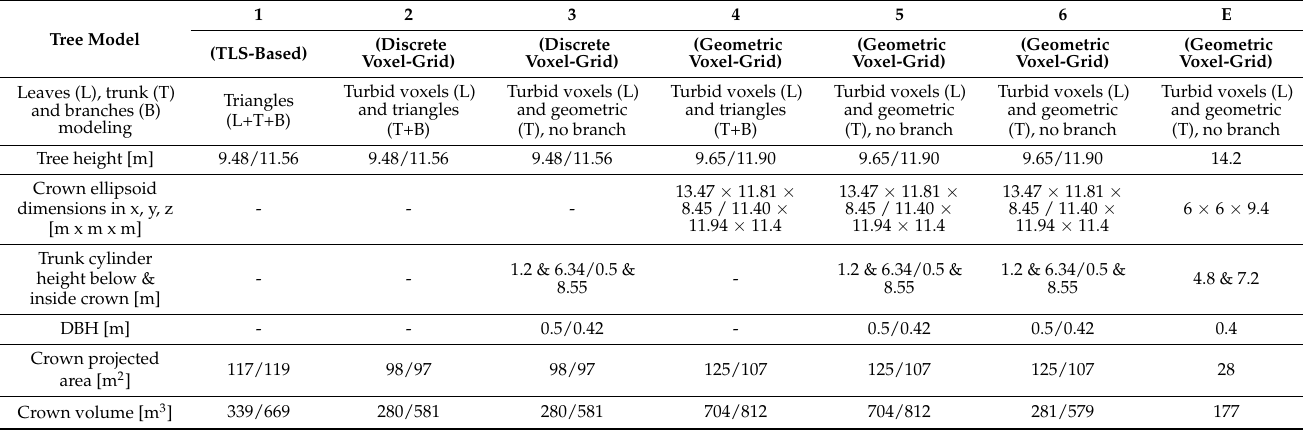
Figure 3. DART 3D mockups of the tree models and NPV (i.e., trunk and branches) for the two species (for global interpretation, dimensions are not respected). Leaves are either represented by triangles (light green color) in the TLS-based tree model n ◦ 1 or simulated as a 3D distribution of voxels filled with turbid medium (dark green color) in the discrete voxel-grid tree model n ◦ 2 and the geometric voxel-grid tree models n ◦ 4 and E. NPV (brown color) are either represented by triangles for the TLS-based and discrete/geometric voxel-grid tree models n ◦ 1, 2, and 4 or a cylinder followed by a cone for the discrete/geometric voxel-grid tree models n ◦ 3, 5, and 6. Table 1. Geometric configuration for each abstract tree model numbered from n ◦ 1 to 6 based on the TLS measurements (magnolia / linden) and for the empirical tree model